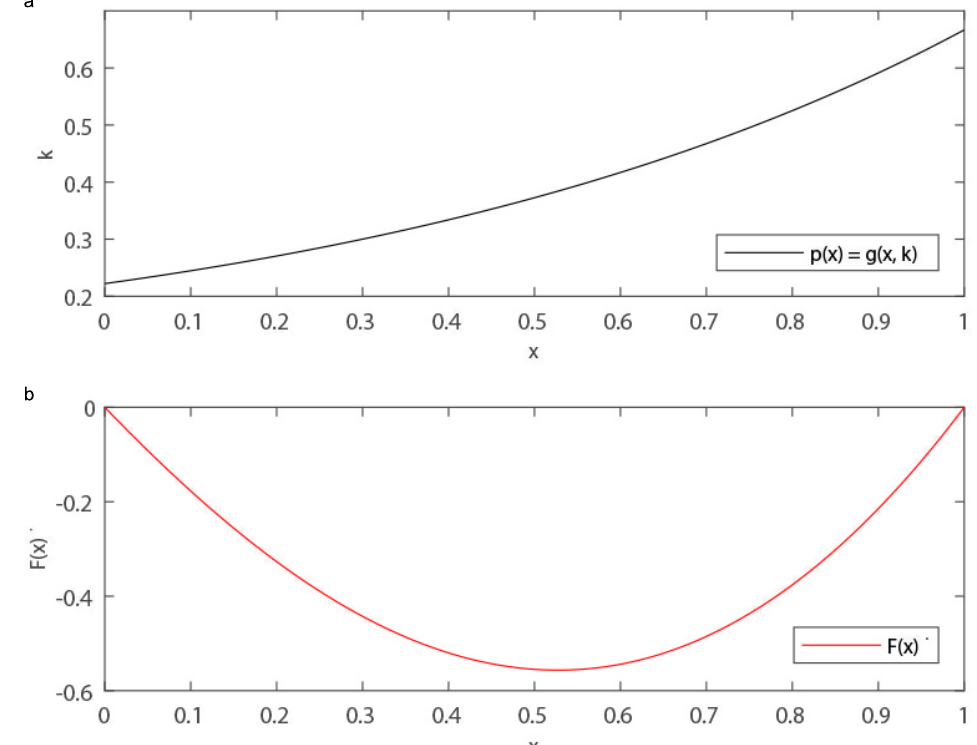
Figure 4. Numerical analysis of possible equilibrium point x 3 in the negative feedback punishment approach. ( a ) All ( x , k ) that satisfy p ( x ) = g ( x , k ) . For each x there is one and only one k that makes ( x , k ) meet the condition. ( b ) This shows that F ( x ) (cid:48) ≤ 0 for every ( x , k ) satisfying p ( x ) = g ( x , k )